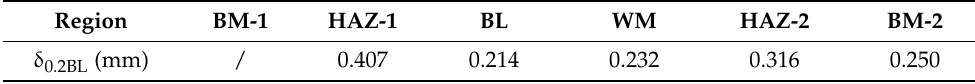
1 represented the dimple. Though HAZ-1 was derived from BM-1, the fracture modes looked completely different. BM-1 presented cleavage brittle fracture mode, while HAZ- 1 showed dimple ductile fracture mode. The large dimples in the fracture of HAZ-1 indi- cated better toughness. The fracture surfaces of BL and WM were mainly dimples, indi- cating ductile fracture models. In addition, the dimples in BL and WM were small, sug- gesting lower toughness. These results were consistent with the δ -R curves in Figure 4. Moreover, some precipitated phases can be observed in the dimples of BL and WM and may play important roles in the fracture behavior. As shown in Figure 6e,f, the fracture surfaces of BM-2 and HAZ-2 were both dimple ductile fracture models. Compared to BM- 2, some dimples in HAZ-2 were large, consistent with better toughness of HAZ-2 when compared to BM-2. Different fracture surfaces reflected variable fracture modes and mechanisms, with microstructure as the main affecting factor.